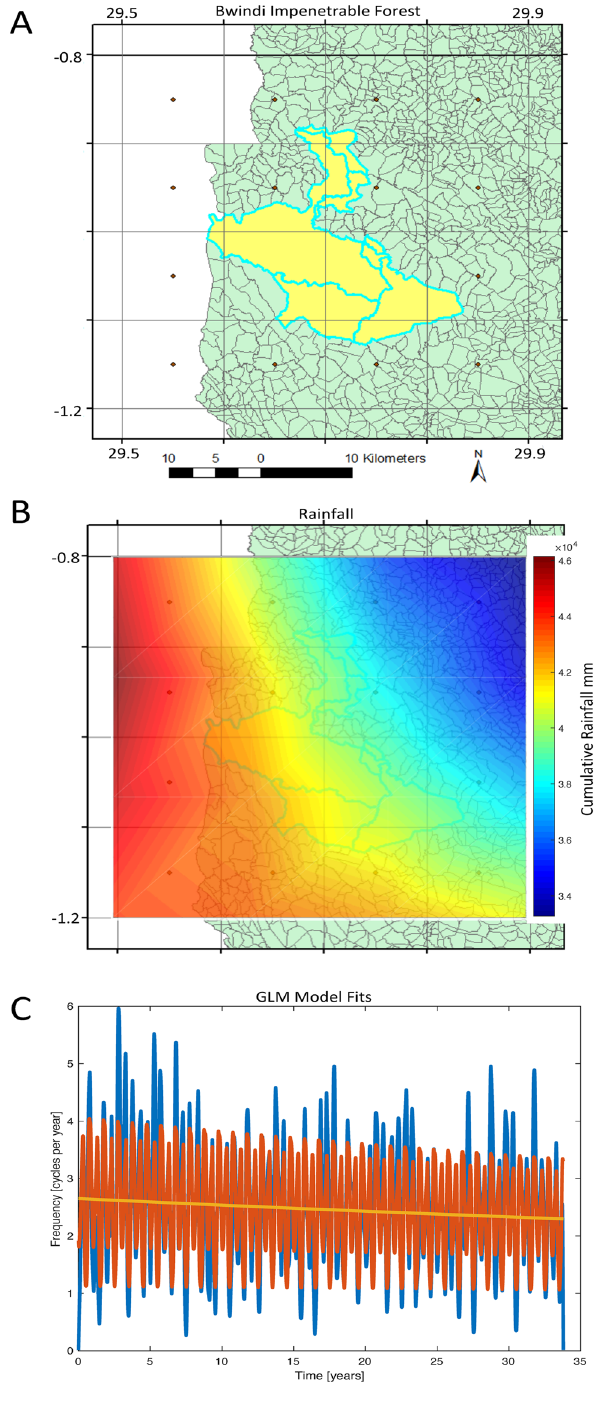
Figure 4. The decrease in rainfall is also reflected within the Bwindi Impenetrable Forest region. This is one of the last remaining habitats of the Mountain Gorilla. ( A ) The Bwindi Impenetrable Forest in Uganda (yellow), covered by 16 of the satellite grids (map created using ArcGIS 10.4.1). The Democratic Republic of the Congo is in white. ( B ) Cumulative rainfall from 1983–2016 with interpolated shading over the Bwindi coordinates. ( C ) Spatially averaged filtered time series of the Bwindi rainfall, overlain with the GLM models as in Fig. 2. Note the substantial rainfall decrease over the